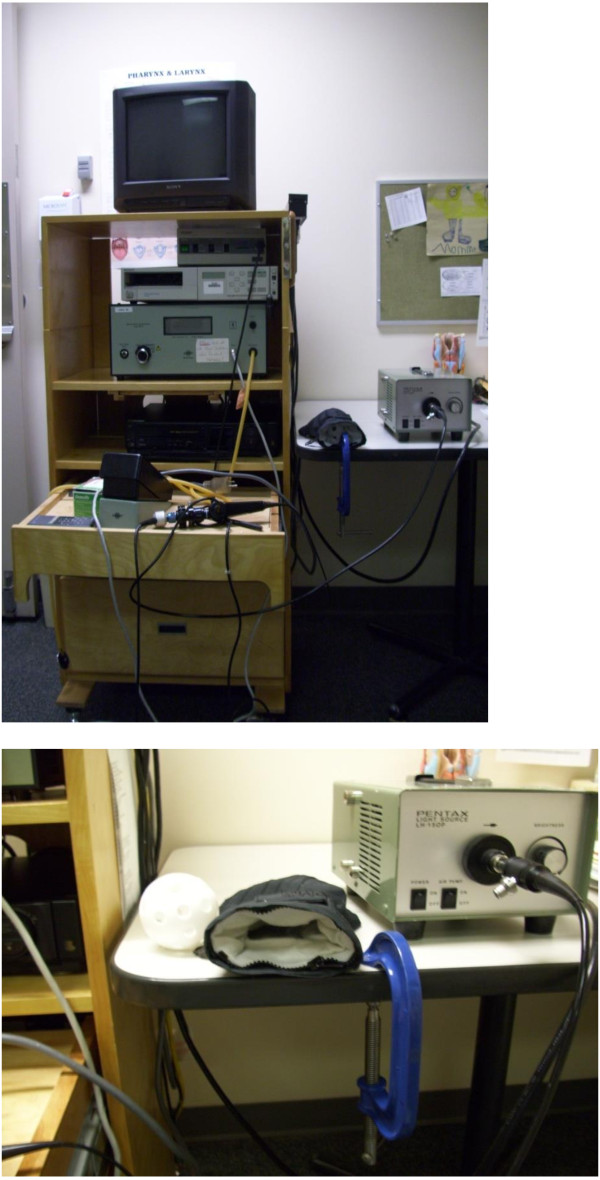
Image of simulator.